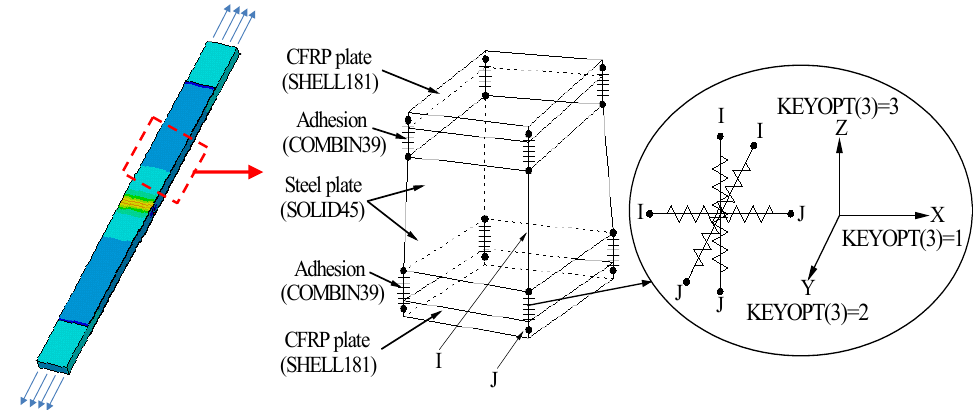
Figure 13. Element type and constraint relationships in the finite element models.